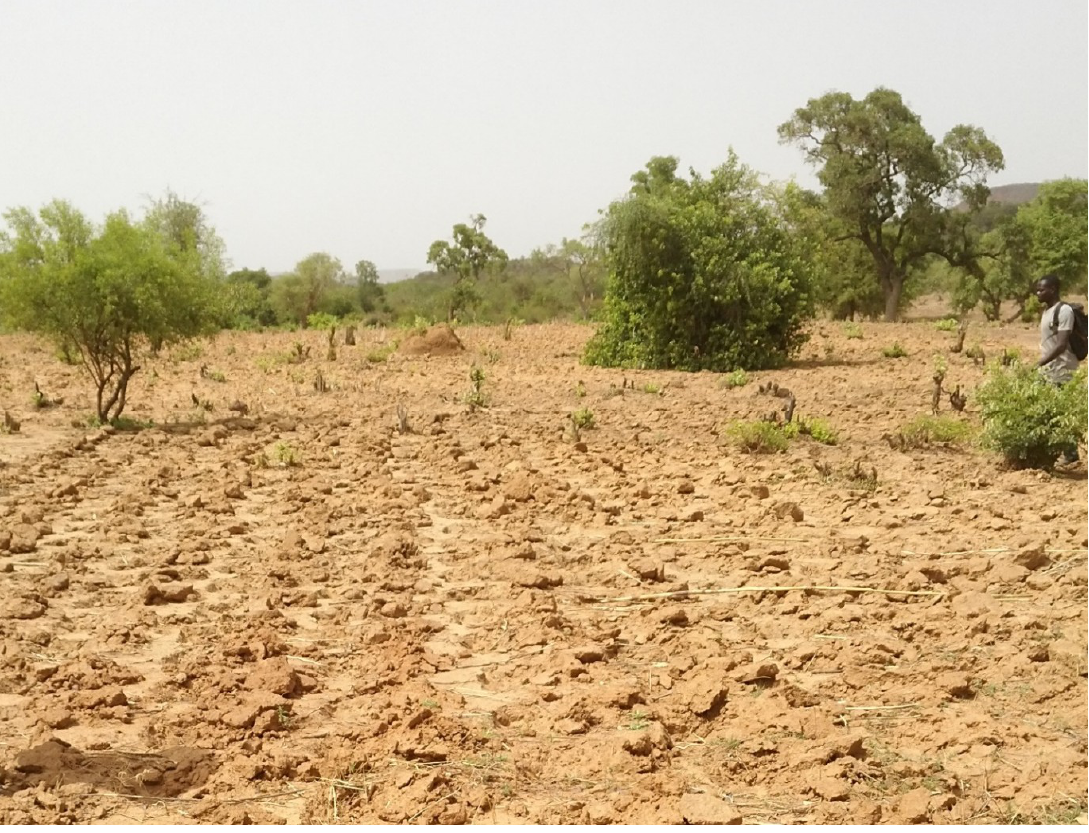
Figure 4. Field treated with zaï, Commune of Kongoussi, July 2017 - Photo by Colin Thor West.